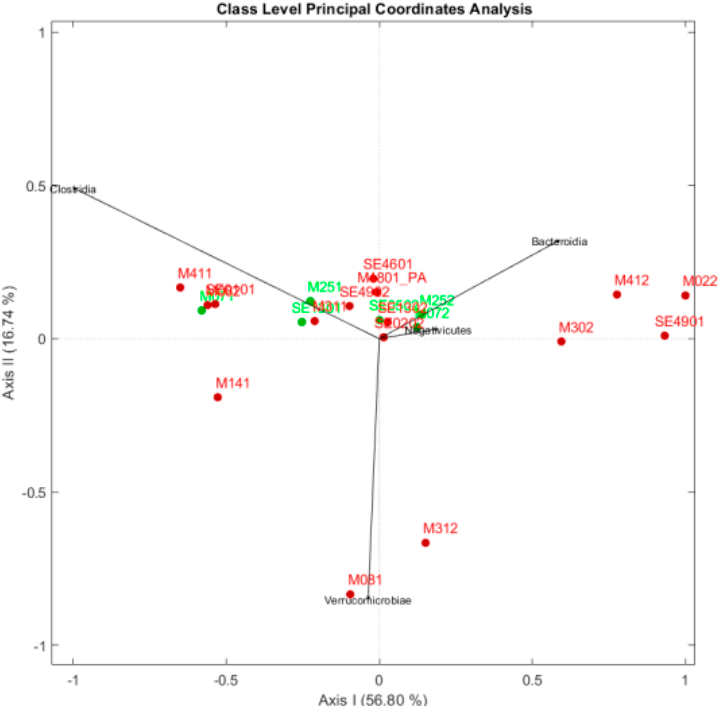
Figure 5. Beta diversity analyses at the class level: PCoA based on Bray–Curtis distance measure. Green: OSA − atherosclerosis. Red: OSA + atherosclerosis.